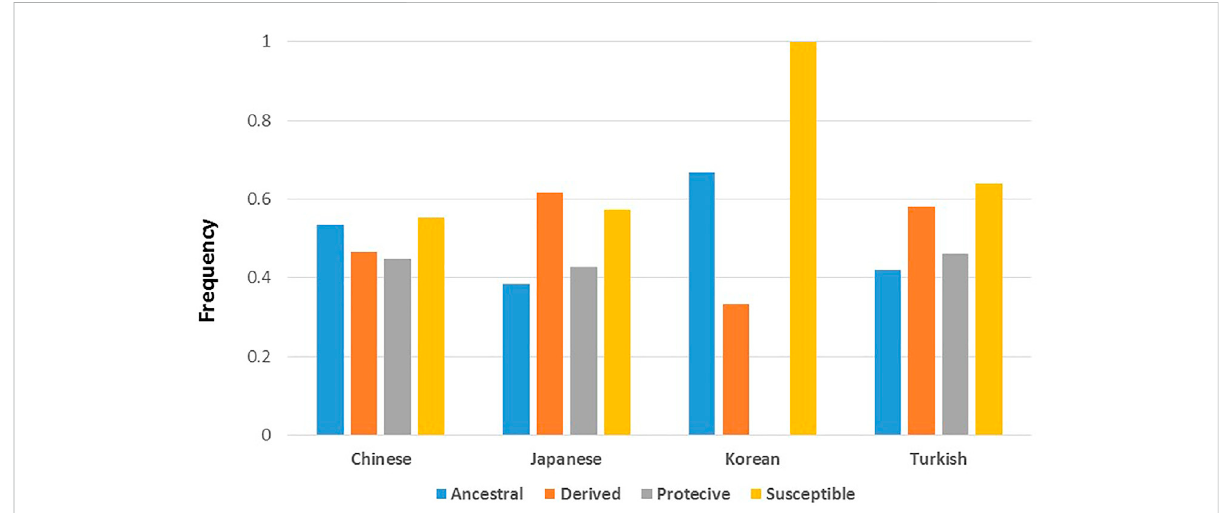
FIGURE 1 Distribution of BD associated variants ’ ancestral and derived allele status, and their effect on BD among the populations with highest BD prevalence. Populations represent study populations where the BD genetic association study was conducted and variants were discovered. Allele count details can be seen in Table